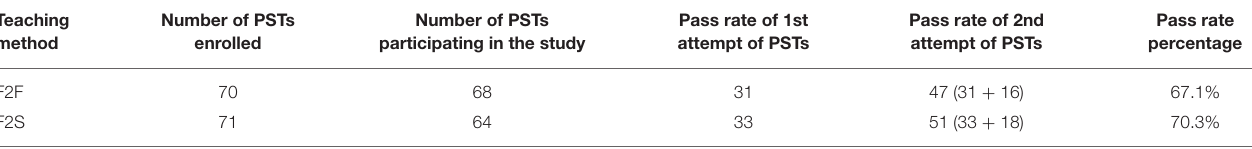
TABLE 5 | Performance comparison between F2F and F2S.